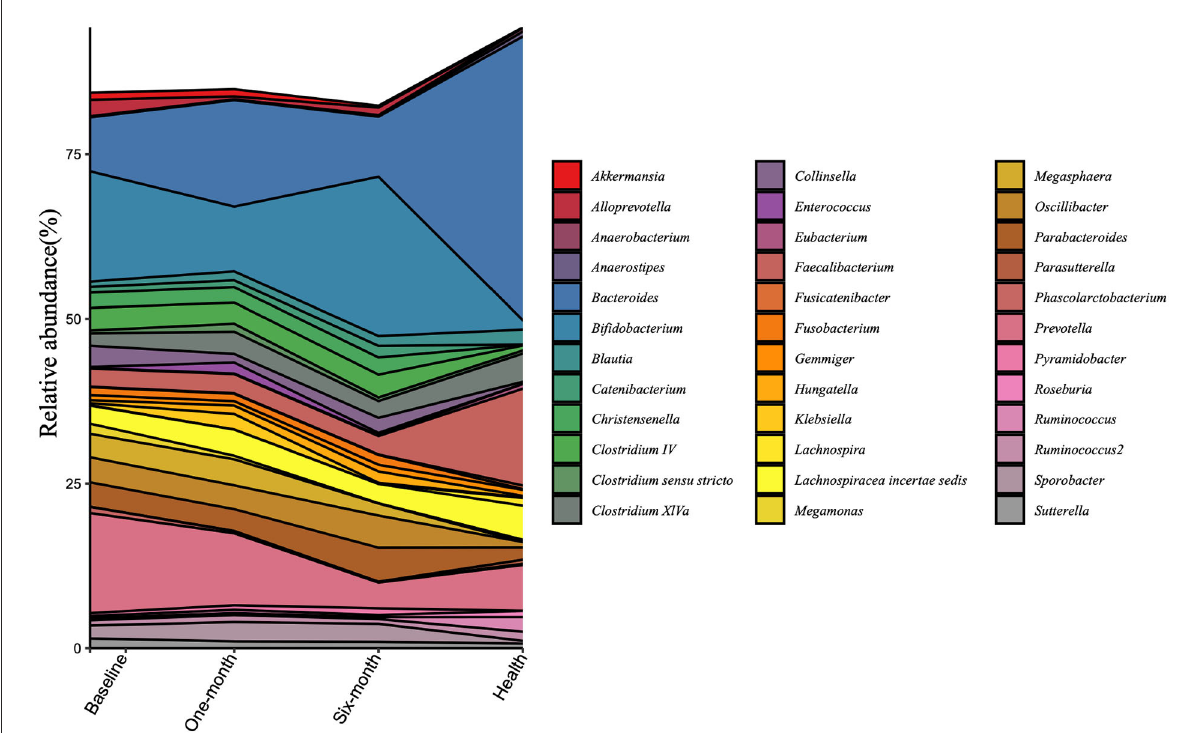
FIGURE3 Changes in the gut microbiota at the genus level are calculated in the patient group and the healthy group at three timepoints. All the top 20 genera of each group were included.